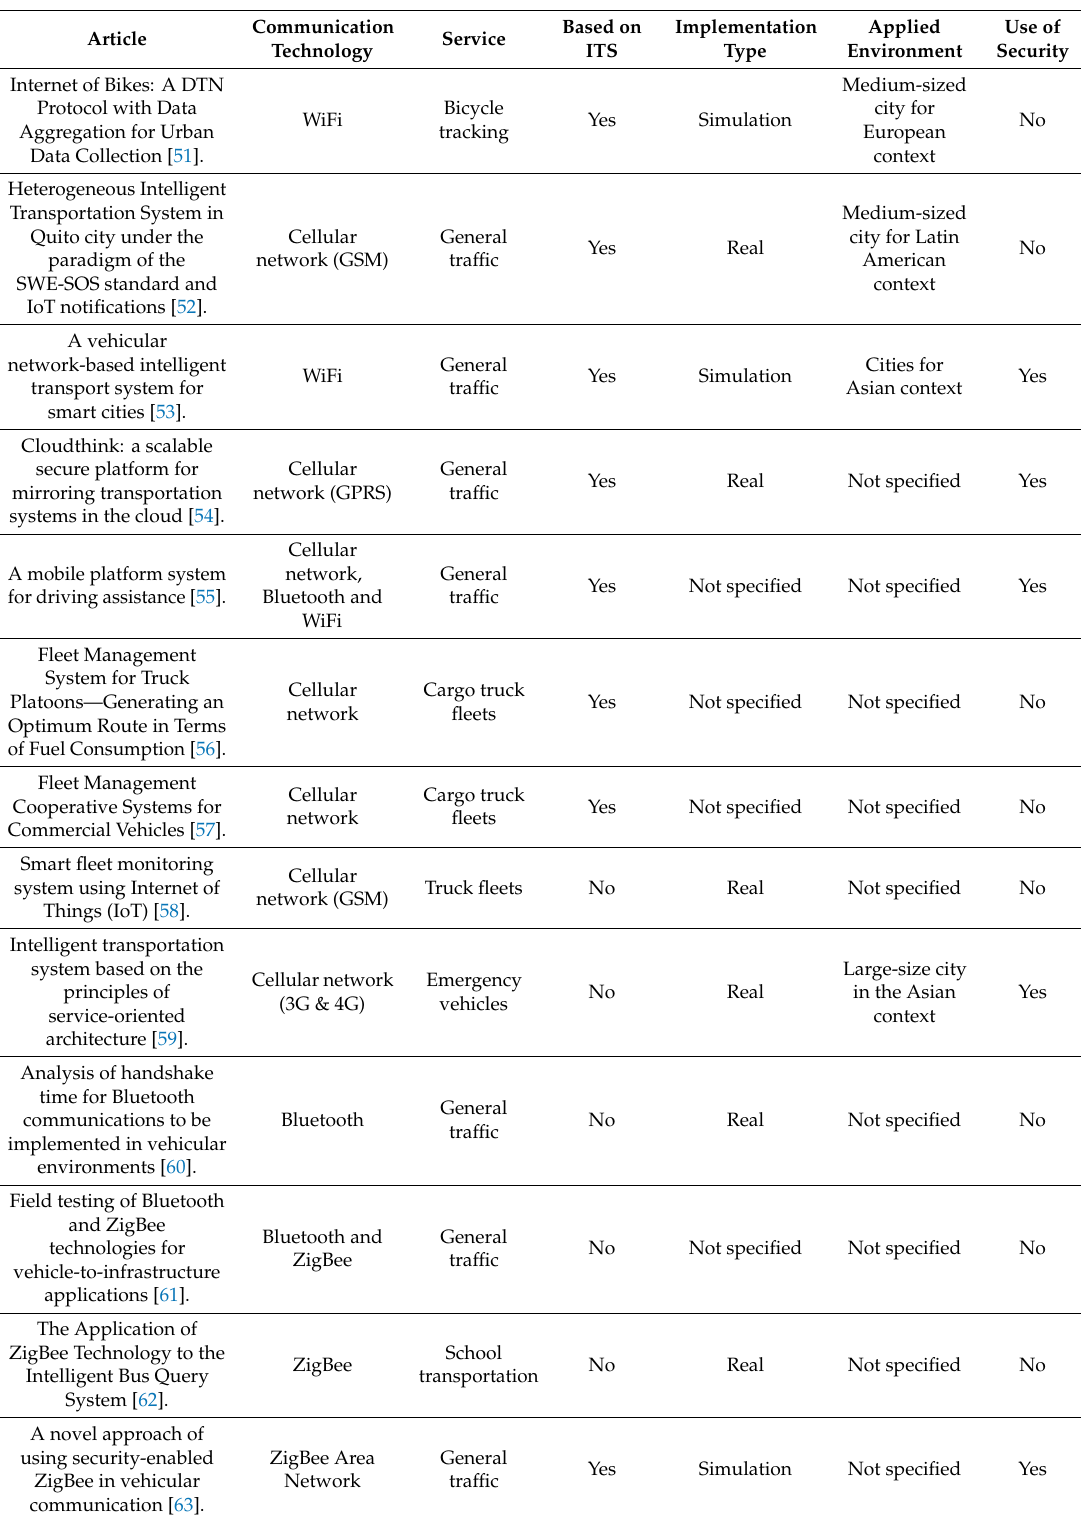
Table 2. Documents of mobility services other than